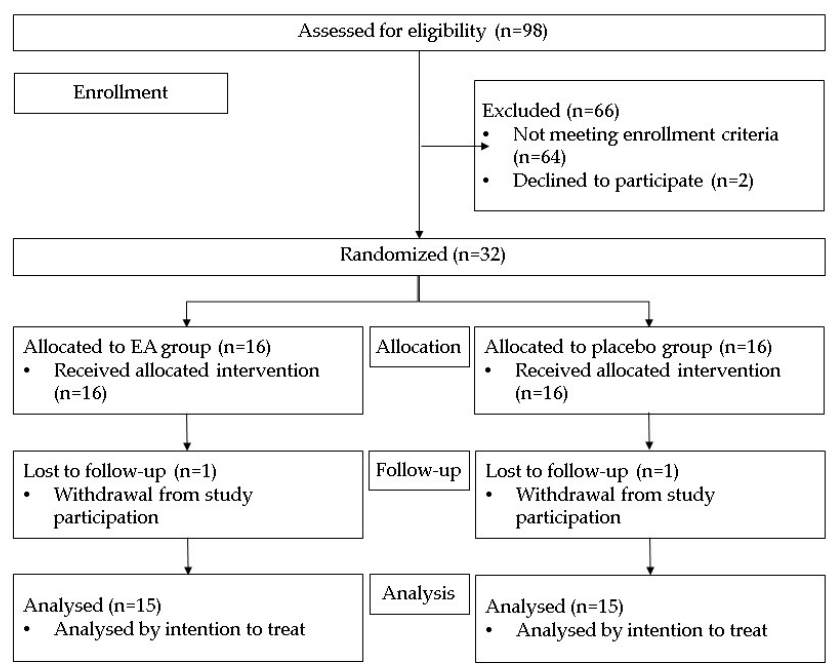
Figure 1. Enrollment flowchart.